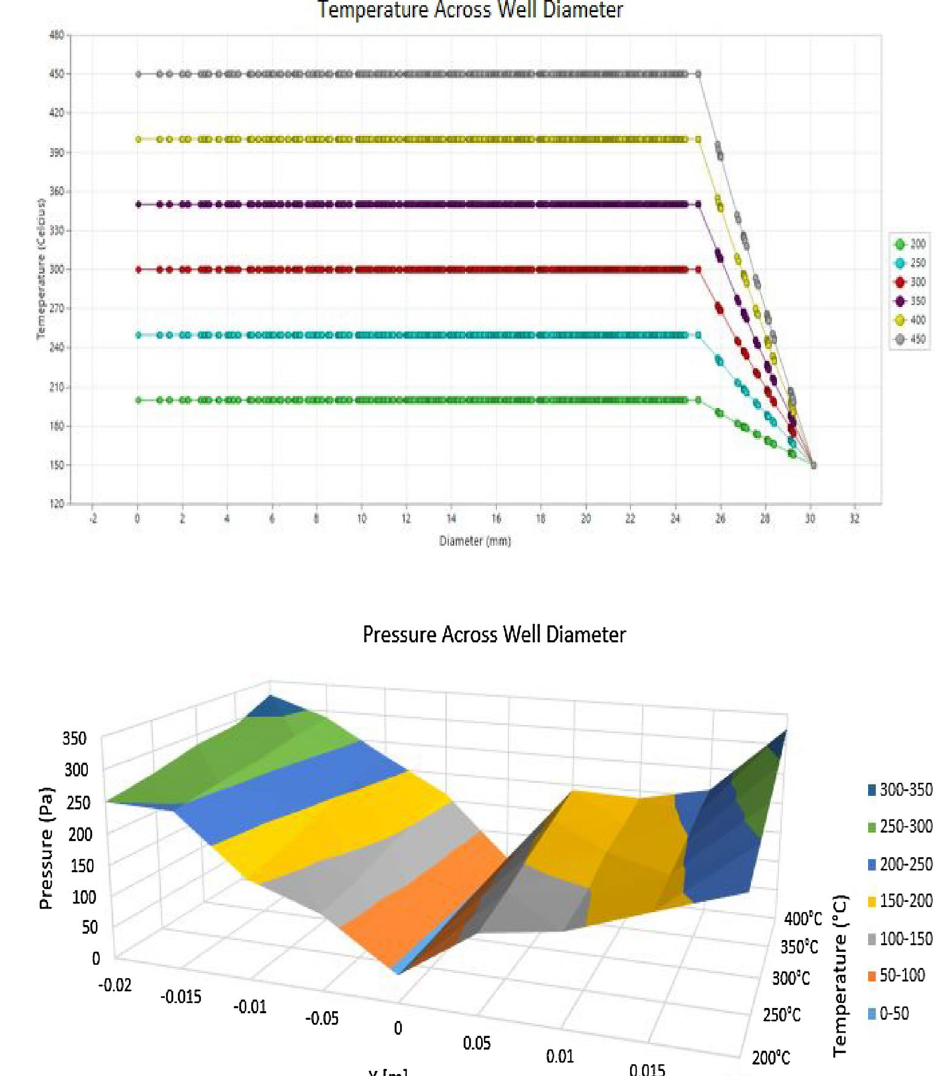
Fig. 9 Variation in temperature across the internal diameter of the well